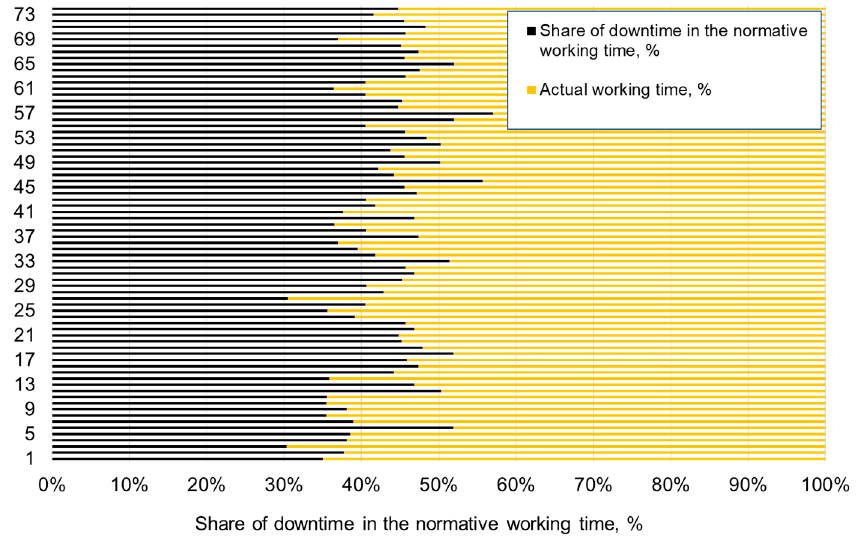
Figure 8. Percentage comparison of time of unscheduled downtime in the shearer’s work during individual shifts.